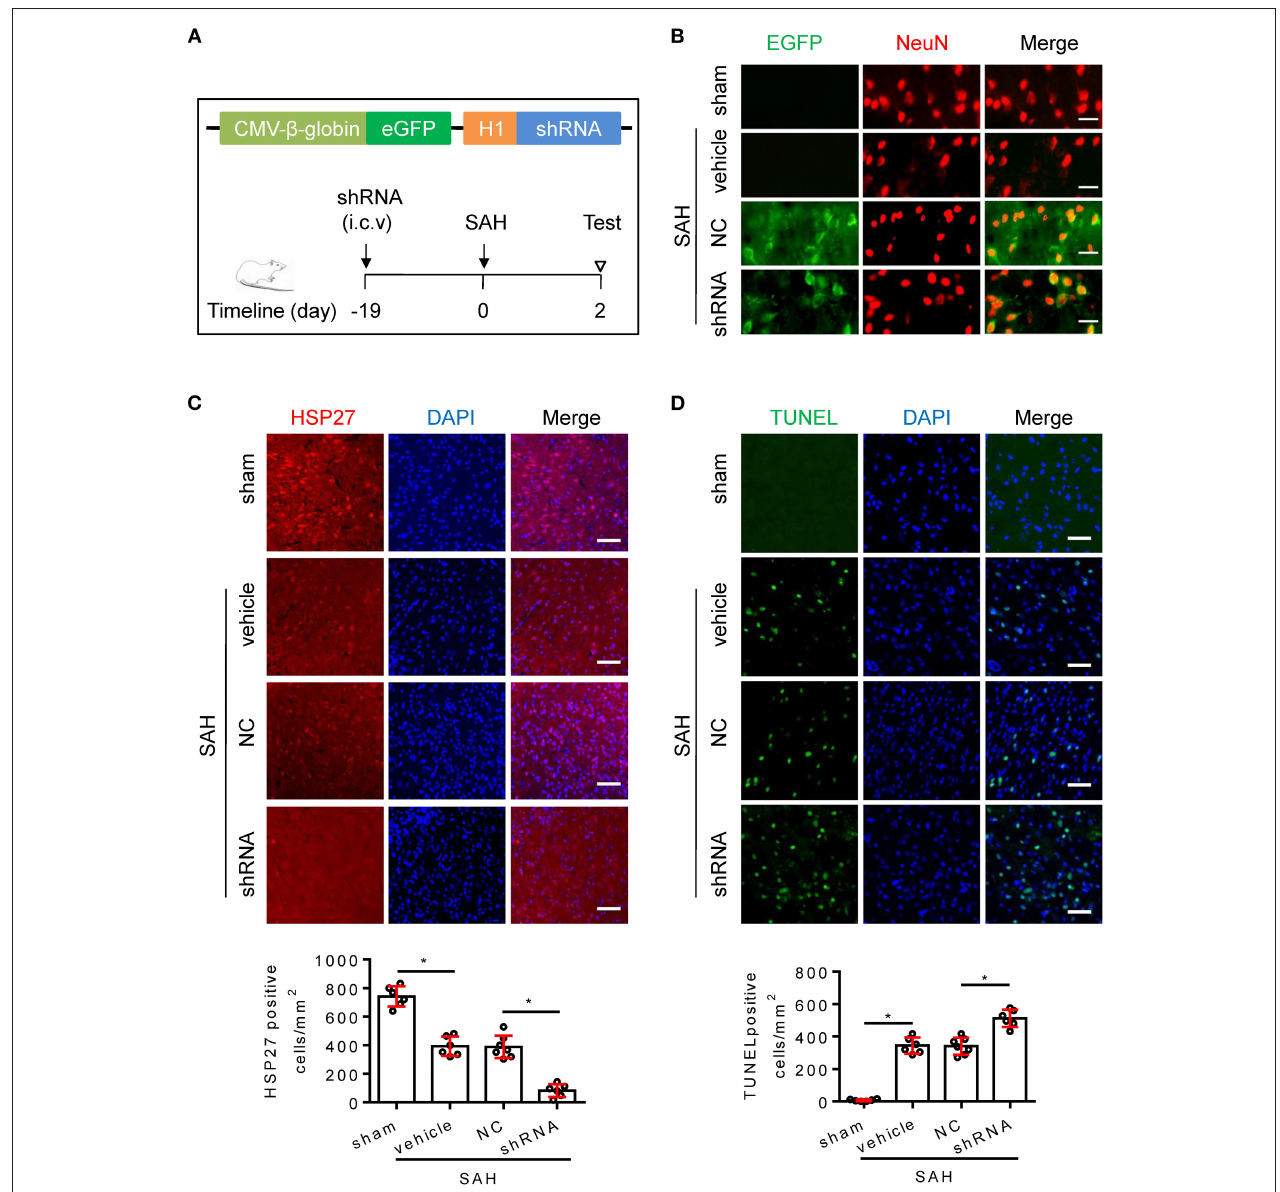
FIGURE 3 | AAV-shRNA targeting HSP27 increased cell apoptosis after SAH in rats. (A) Schematic of AAV vector encoding shRNA and experimental design. (B–D) Coronal sections from the sham ( n = 6), SAH + vehicle ( n = 6), SAH + negative control of shRNA (SAH + NC, n = 7), and SAH + HSP27 shRNA (SAH + shRNA, n = 6) group reperfusion on day 2 after SAH, subjected to immunostaining for the neuronal marker NeuN (red) or HSP27 (red) or TUNEL (green) in the basal cortex. (B) Representative images showing AAV-eGFP-shRNA expression (indicated by EGFP, green) in the neurons (NeuN staining, red) in the basal cortex, scale bar = 50 µ m. (C,D) Quantification was performed by counting the HSP27 or TUNEL positive cells per mm 2 region in the basal cortex, scale bar = 50 µ m. Data are mean ± SD, * p < 0.05, ANOVA with Bonferroni’s multiple comparisons